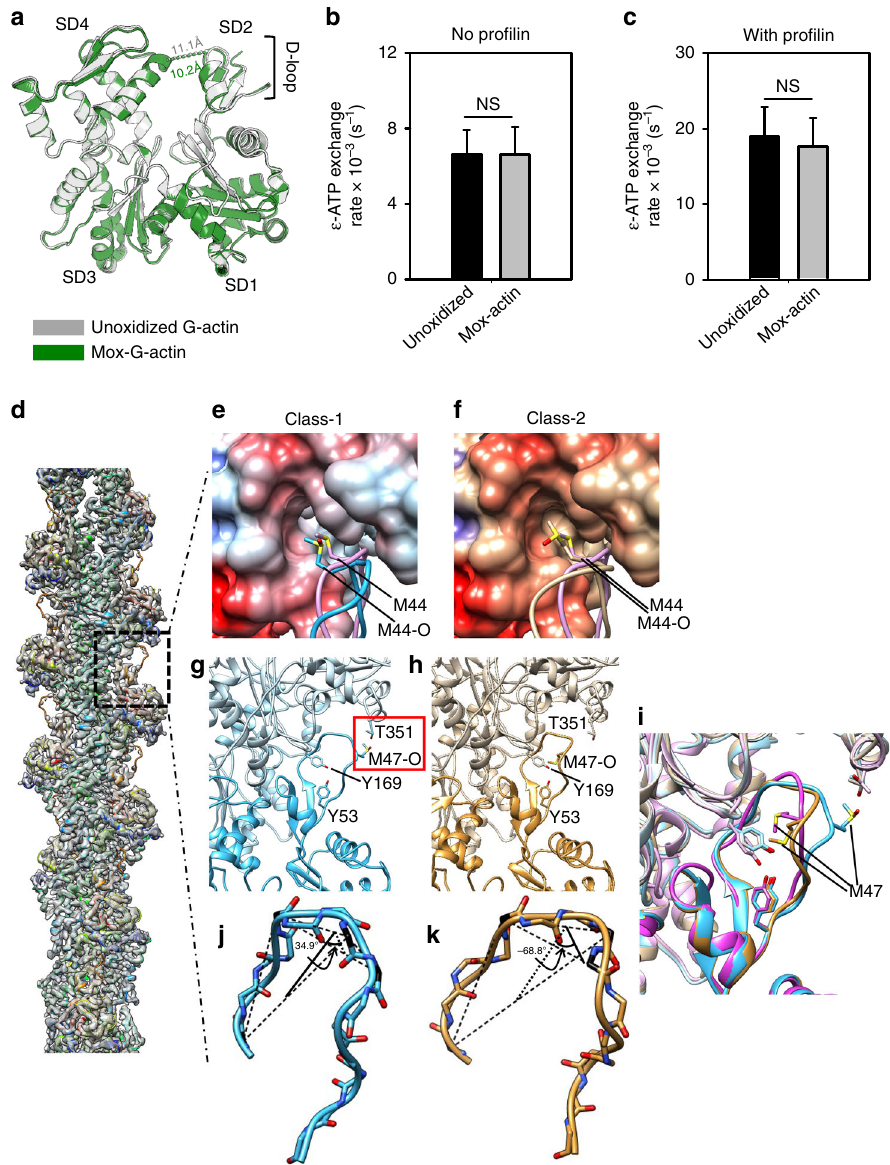
Fig. 2 Atomic structures of monomeric and fi lamentous Mical-oxidized actin. a Overlay of the crystal structures of Mical-oxidized (Mox) Ca-ATP-G-actin (2.7 Å resolution, green) and unoxidized (PDB# 1EQY) 18 G-actin (gray) both in complexes with gelsolin segment-1. Mox-G-actin was crystallized in 7.5% PEG-6000, 150 mM NaCl, 50 mM imidazole, pH 6.6. Width of nucleotide-binding cleft is shown with dashed lines in both structures (10.2 and 11.1 Å). Actin subdomains (SD) 1 – 4 and the location of the D-loop are indicated. b , c Rates of nucleotide ( ɛ -ATP) exchange in Mical-oxidized and unoxidized G- actin (1 µ M). No signi fi cant differences in their ɛ -ATP exchange rates were detected either in the absence b or presence of 0.1 µ M of human pro fi lin c . Error bars represent s.d. ( n = 11 and 10 measurements (with and without pro fi lin, respectively) from 3 independent repeats); NS — not signi fi cant ( P > 0.05), two- tailed Student ’ s t -test. d – k CryoEM structure of Mox-F-actin at 3.9 Å resolution. 3D structure classi fi cation with RELION identi fi ed two distinct structural classes (Class-1 and Class-2) d Overall cryoEM map of Mox-F-actin computed from all particles (gray shaded surface) is fi tted with the atomic model of Class-1 structure (ribbons, rainbow-colored by amino acid sequence). The region boxed with the broken square is shown in zoomed view in ( e – i ). e , f Orientation of the M44 side chain in Class-1 e and Class-2 f of Mox-F-actin compared to unoxidized (canonical actin model) 19,20 . Oxidation by Mical compromises the geometric surface complementarity between the hydrophobic cleft and the subdomain 2 (SD2) region of actin. g – i Two different conformations of the D-loop in the atomic models of Class-1 and Class-2 of Mox-F-actin. Zoomed views of the SD2 regions of the atomic models (ribbons) of Classes 1 (cyan, left, g ) and 2 (tan, middle, h ). Overlay of the SD2 regions of Classes-1 and 2 of Mox-F-actin and canonical F-actin (pink, right, PDB: 5JLF) is shown in i . j , k Conformational changes in the D-loop of Classes-1 j and 2 k of Mox-F-actin as measured by a change in the dihedral angle (torsion) between the plane-1 (de fi ned by C α atoms of residues 39, 43, and 46) and plane-2 (de fi ned by C α atoms of residues 43, 46, and